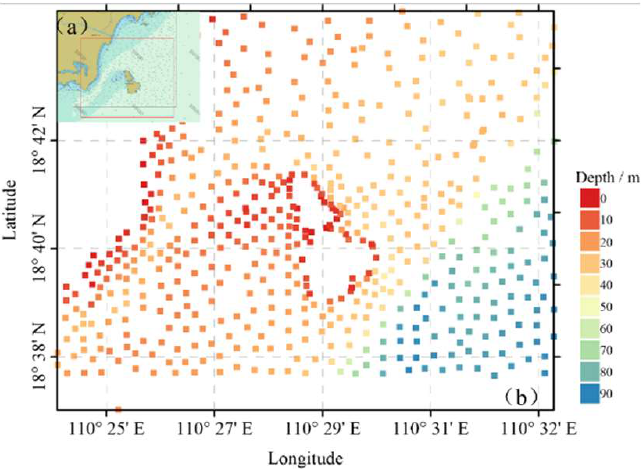
Figure 3. The chart data of the study area: ( a ) the water depths of sea area around Dazhou Island on the Chart Sever website, the selected depth points were in the red box; ( b ) collected water depths ranged from 0 to 90 m.